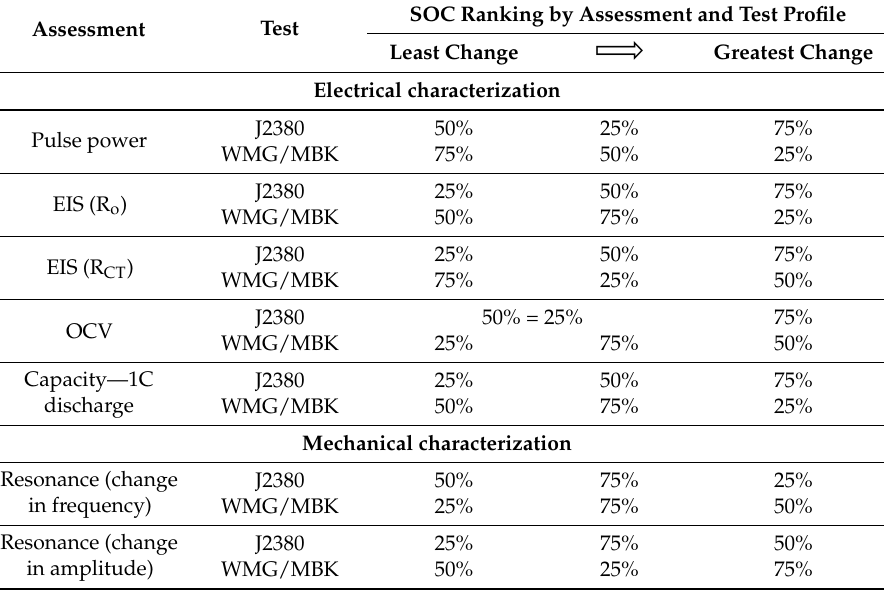
Table 8. Assessment ranking of state of charge (SOC) by